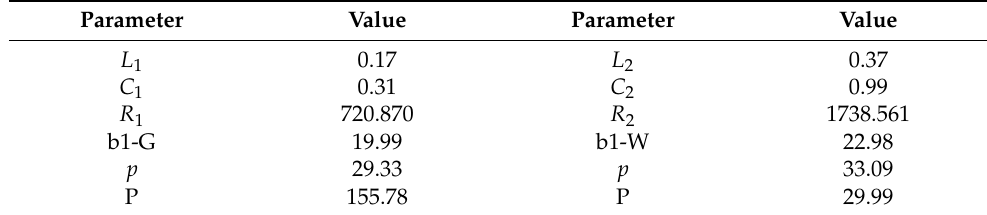
Table 3. Results of other training parameters of DDPG.